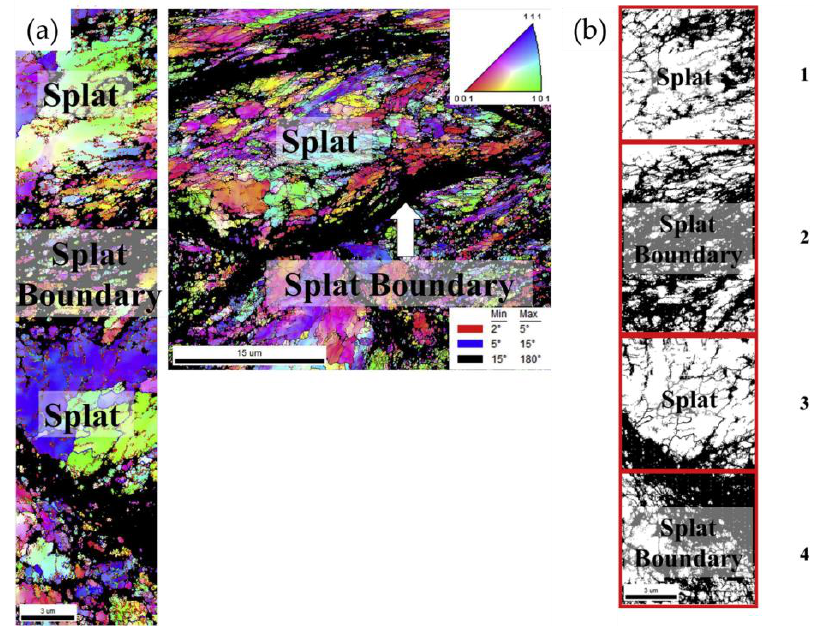
Figure 5. ( a ) Inverse pole figure (IPF) map of the splat and splat boundaries in CS IN 625 coating microstructures. A noticeable grain fragmentation caused by high-strain-rate deformation was observed for both the splat and splat boundaries, ( b ) low-angle (in grey color) and high-angle (in black color) boundaries related to the splats (regions 1 and 3) and splat boundaries (regions 2 and 4). Reprinted from Chaudhuri et al. [65], Copyright 2017, with permission from